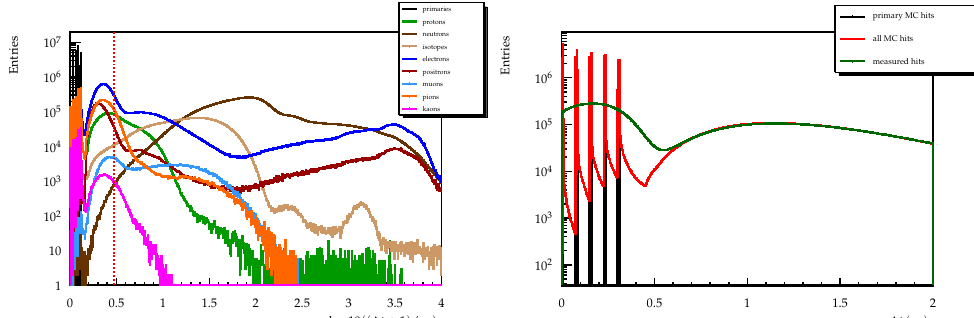
Figure 3. ( Left ): Distributions of the true arrival time in the tracker sensors of primary 1 TeV protons (black) and of the secondary particles generated by interactions of the primary protons with the detector materials. Each entry represents the timing information associated to one hit in the tracker. A dashed vertical red line indicates a delay, from the first primary hit, of 2ns, that is the time range in the figure on the right. ( Right ): for the same events, the inclusive distribution of true arrival times (red) with the superimposed distribution of measurements assuming a timing resolution of ∼ 100ps (green). The distributions are obtained out of ∼ 5million generated events. In the distributions, we consider “hits” all the energy depositions in the sensitive volumes above a certain threshold ( ∼ 10keV, that represents the amount of ionization energy deposit resulting in a readout signal comparable to the typical FEE noise), also including energy depositions different from